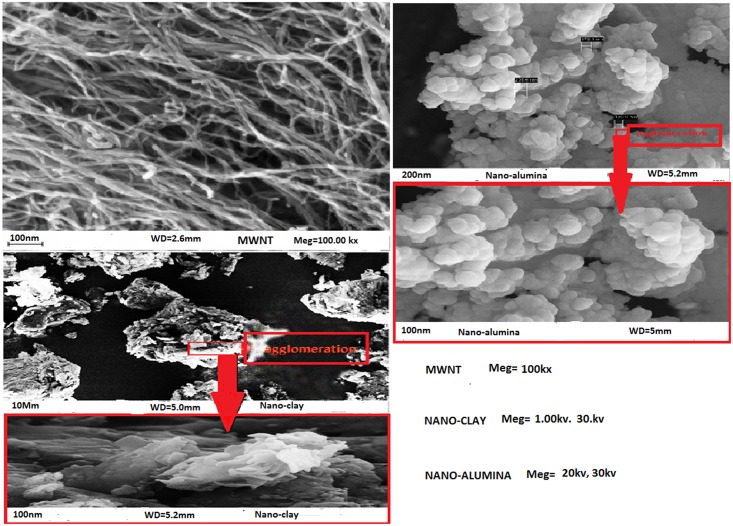
Fesem images of MWNT(a), nano-clay(b), nano-alumina (c).